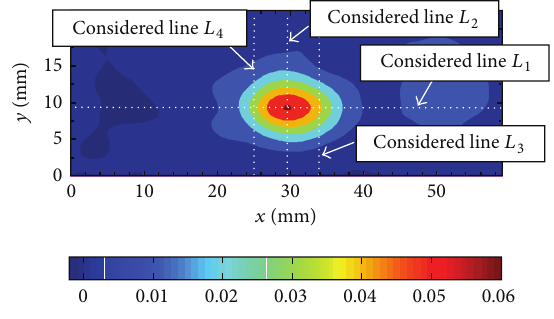
Figure 5: Locations of the considered lines.